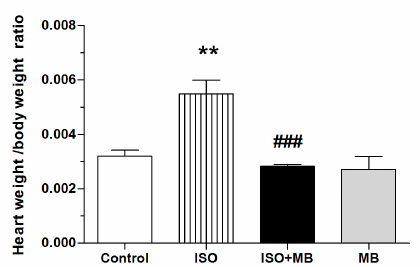
Figure 4. Effects of ISO and treatment with M. bijugatus extract on weight/body weight ratio. Depicts the ISO (85 mg/Kg) induced myocardial damage through an elevation of the heart weight to body weight ratio. This was significantly reduced in the MB (100 mg/Kg) treated groups. ** p <0.01 vs. control; ### p < 0.001 vs. ISO, n = 5.